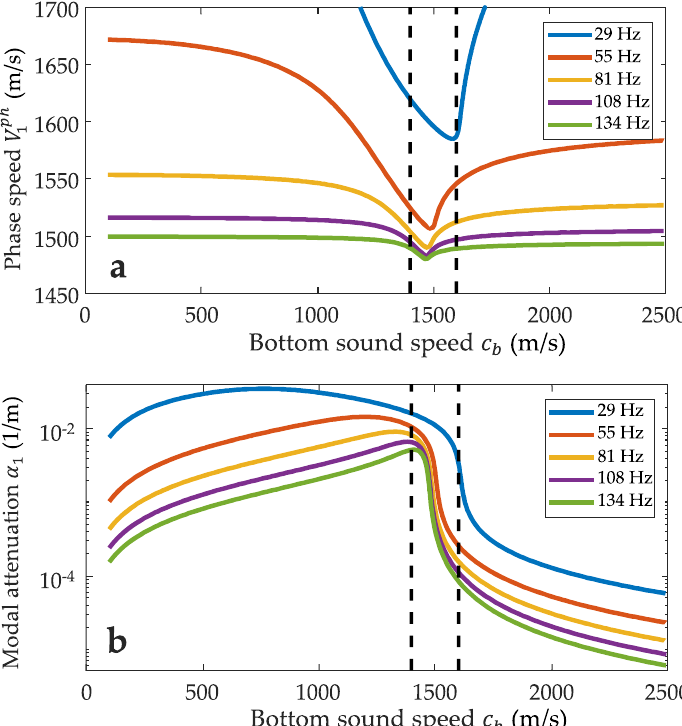
Figure 2. Dependence of ( a ) the modal phase speed 𝑉 𝑙𝑝ℎ and ( b ) attenuation 𝛼 𝑙 on the sound speed in the bottom 𝑐 𝑏 for the first mode at different frequencies. Vertical dashed lines limit the transitional region under consideration.